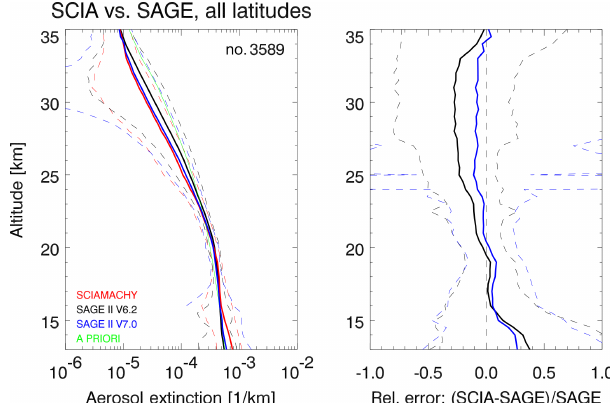
Figure 1. Left panel: comparison of average co-located SAGE II version 6.2 (black solid line) and version 7.0 (blue solid line) and SCIAMACHY version 1.1 (red solid line) aerosol extinction pro- files with standard deviation (dashed lines). The green line corre- sponds to the a priori extinction profile used for the SCIAMACHY retrievals. The number in the top right corner shows the number of co-locations averaged. Right panel: mean relative difference be- tween SCIAMACHY and SAGE II (version 6.2 in black and ver- sion 7.0 in blue) aerosol extinction profiles with standard deviation